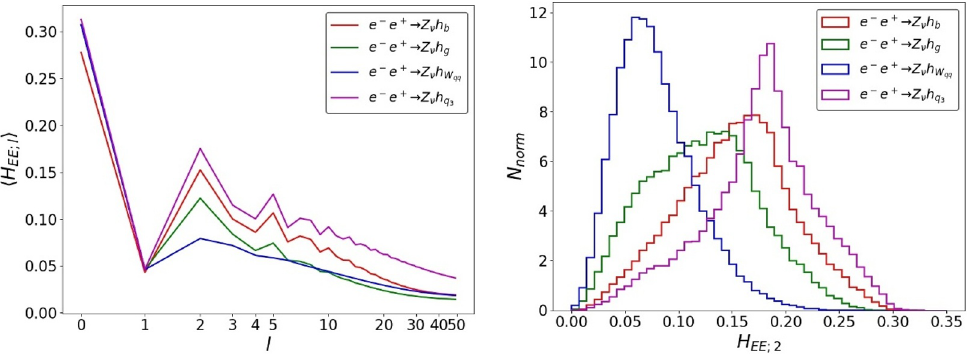
Figure 4 . FW spectra of h H EE ; l i (left) and event distributions of H EE ;2 (right) for the two-jet samples.